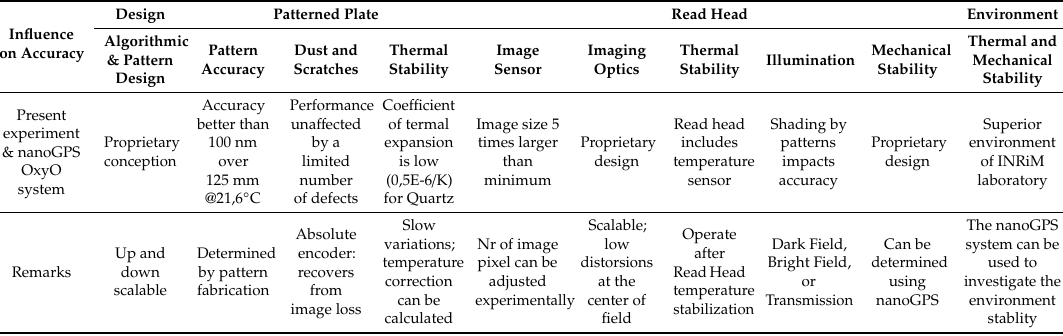
Table 1. Impact on accuracy of di ff erent elements of nanoGPS encoder and its